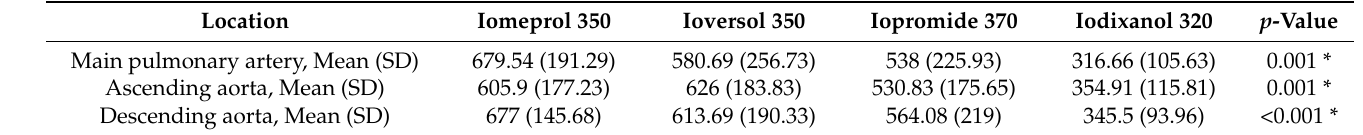
Figure 2. Comparison of the average HU in the ascending aorta, descending aorta and main pulmonary artery, grouped by the contrast agent used. Table 3. HU average values of the large